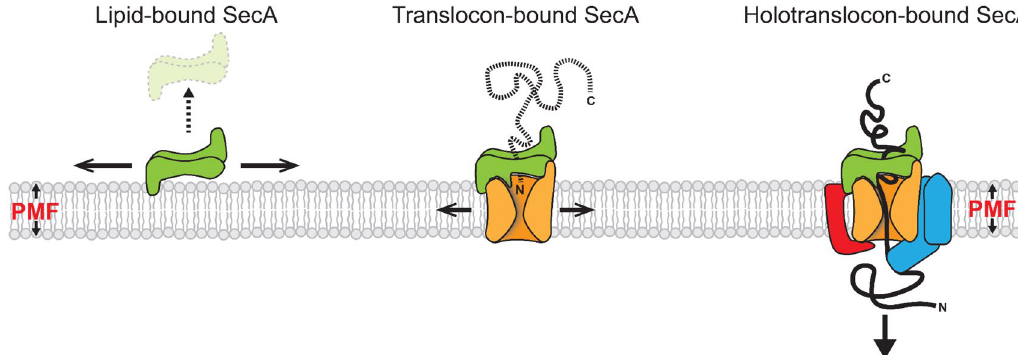
Figure 7. Explanatory model of SecA diffusive populations in living cells. SecA (Green), SecYEG (orange), YidC (red), and SecDF (blue). Based on the diffusion characteristics of SecA observed in E. coli cells, and available literature data, we propose that SecA exists in at least three distinct states. (1) A lipid-bound state: SecA is associated at the cytoplasmic membrane in a “scanning” mode, diffusing rapidly along the membrane surface, possibly waiting for substrates to translocate. Although the observations demonstrate that SecA is predominantly associated with the cytoplasmic membrane, a very small cytosolic pool of SecA is also present. (2) A translocon-bound state: SecA exhibit a diffusion rate of a membrane protein. Since SecA does not poses the characteristics of an integral membrane protein, we propose that in this either is an idle or protein translocation engaged state of SecA. SecA is only transiently engaged in this state. (3) A holotranslocon- bound state: the transiently immobile population of SecA is likely bound to a large protein complex, the